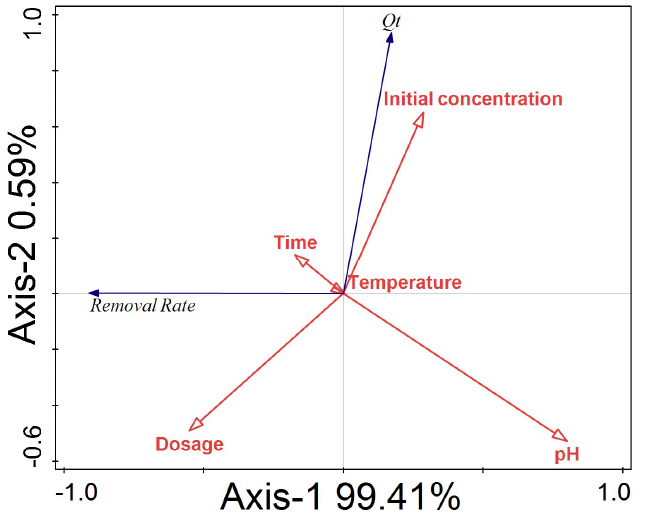
Figure 6. Redundancy analysis of removal rate and adsorption capacity with different environmental factors.